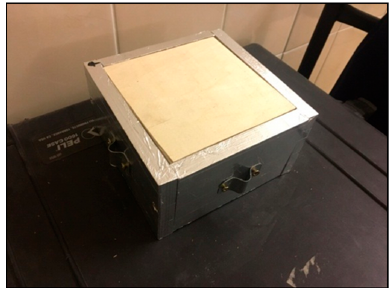
8 of 29 Figure 2. Schematic of the experimental setup: 1––laboratory autotransformer; 2––heating element; 3––pallet; 4––wood sample; 5––cuvette; 6––stopper; 7––heat blower; 8––burner; 9––tripods; 10–– samples of firebrands; 11––bracket. The experimental setup included: a JADE J530SB infrared camera with an 2.5–2.7 micron optical filter that records the temperature in the range of 300–800 °C; a Canon HF R88 video camera for evaluating the ignition delay and the behavior of firebrands after falling onto the surface of the wood building material samples; an AND MX-50 humidity analyzer for controlling the humidity of the samples; an AND HL 100 laboratory scales for controlling the initial mass of firebrands and the mass of wood samples. In all experiments, pine twigs with a diameter of 6–8 mm and a length of 40 ± 2 mm were used as the simulators of firebrands. Previously [22], the experiment was conducted on the ignition of wood samples from a pine construction board as a result of exposure to flaming and glowing pine bark firebrands. The experimental method was similar. It was concluded that the probability of ignition of wood samples increases with increasing firebrand size, as well as with increase in wind speed rate. The size of pine twigs (40 mm